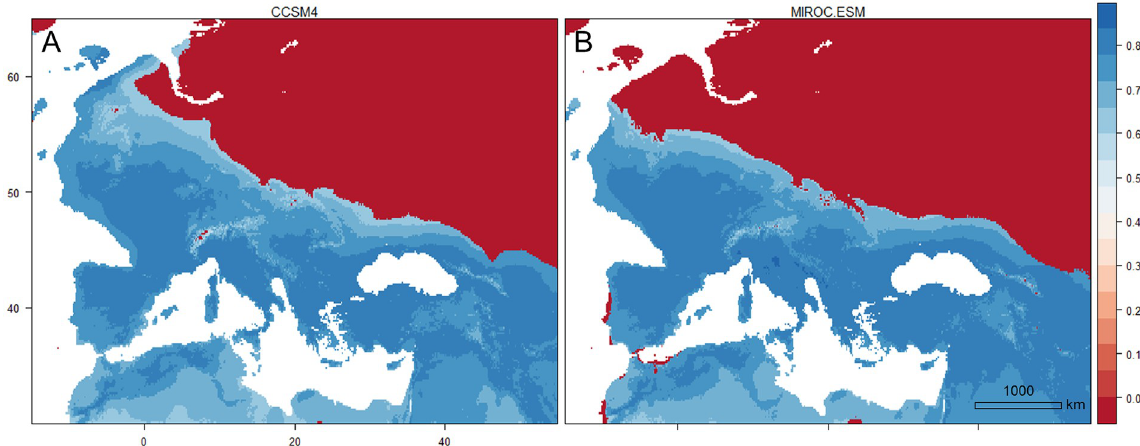
Fig 10. Mobility-oriented parity (MOP) analysis comparing current conditions of the calibration region for stag beetle distribution modelling with conditions during LGM. (A) Results for the CCSM4 scenario and (B) the results for MIROC-ESM. The closer the values are to 1 (dark blue) the more comparable environments are to current conditions. Areas with value 0 (dark red) are out of range for one or more environmental variables (strict extrapolation).